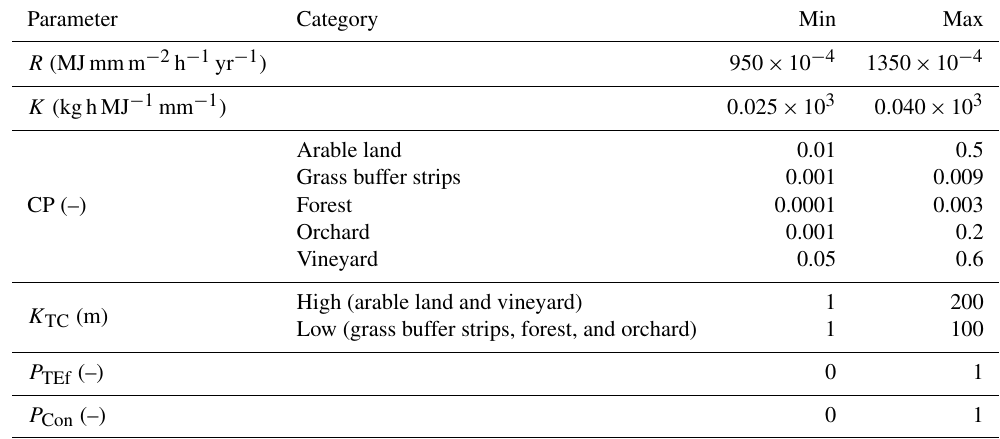
Table 2. Minimum and maximum parameter values sampled during the Monte Carlo